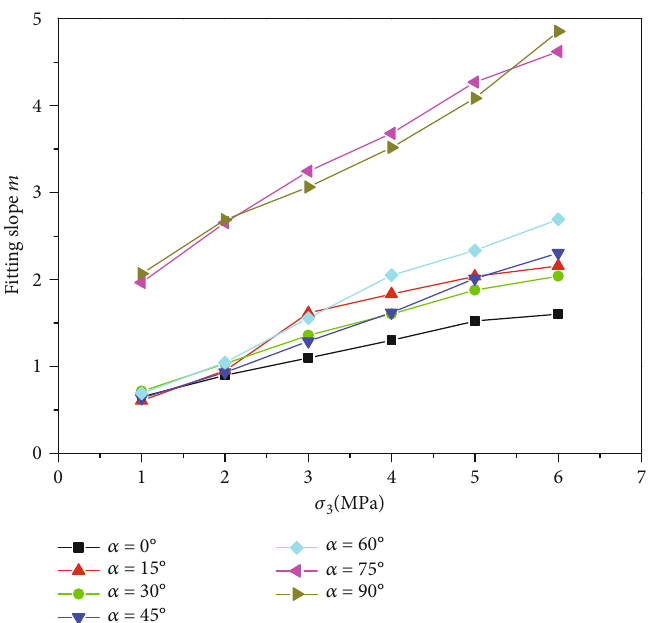
Figure 10: Changes in the characteristic curve of the fi tting slope m with the minimum principal stress σ